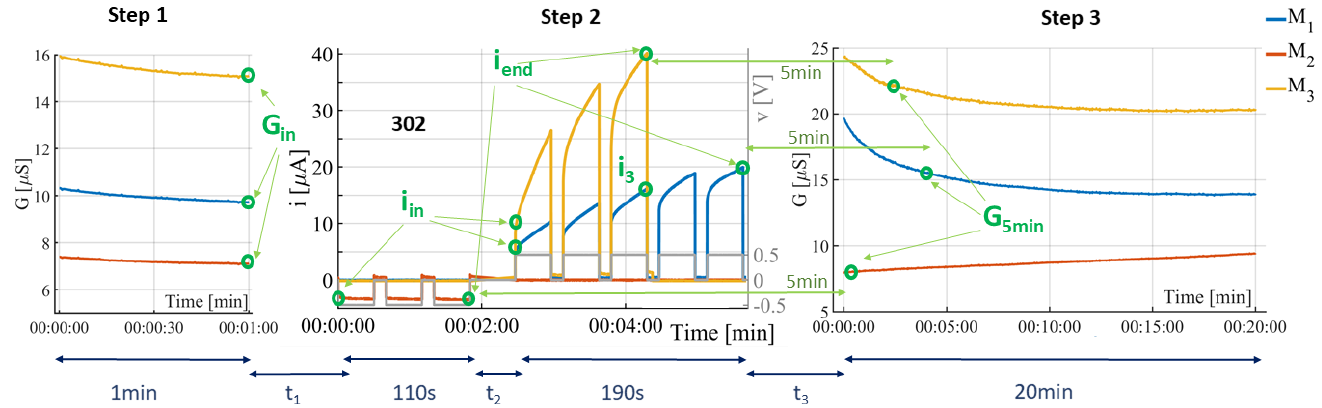
Fig. 2: Results of one whole recording of test subject “A” before exercise. Parameterization and durations are visualized. The initial conductance was measured for around one minute in step 1. In step 2, DC voltage pulses were applied to change the conductance of the skin (non-linear measurements). The procedure was different for the two different numbers (302 and 123); this example shows the procedure for number 302. An example measurement for 123 can be seen in Fig. 3. In step 3, the AC conductance was measured for 20 minutes. The start of each measurement was done manually within the software and thus the durations t 1 , t 2 , and t 3 between measurements varied slightly among the test sessions. The initial conductance, here defined as the last conductance value within step 1 is labeled as G in . Within step 2, i in and i end are the current values at the beginning and the end of each DC voltage pulse series. For the further analysis, the conductance values at specific times (3, 5, 10, 15, and 20 minutes) related to the time of the last DC pulse (which is different for each electrode) were used. In the plot to the right (step 3), only the conductance values at minute five, G 5min , are